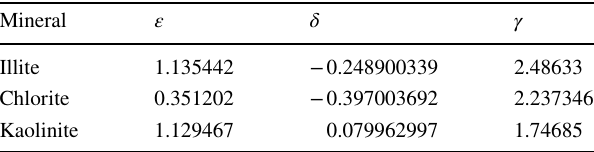
Table 3 Thomsen’s anisotropy parameters calculated using the data published in Katahara (1996)